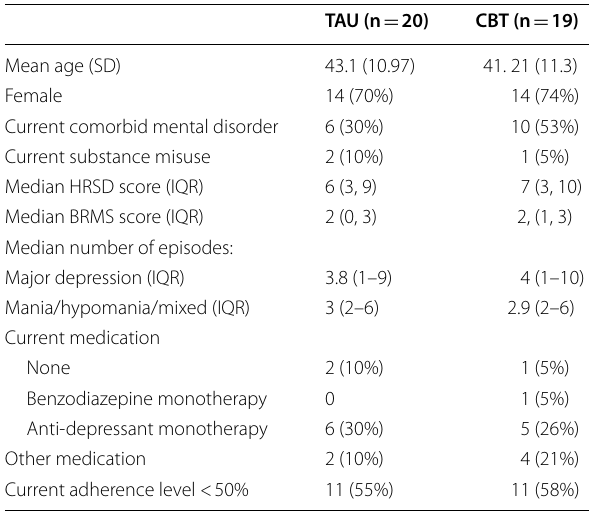
Table 2 Key characteristics of individuals with suboptimal or no mood stabilizer